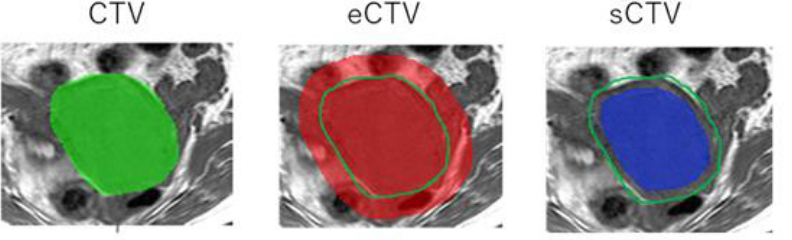
Table 2. Feature type and associated features.